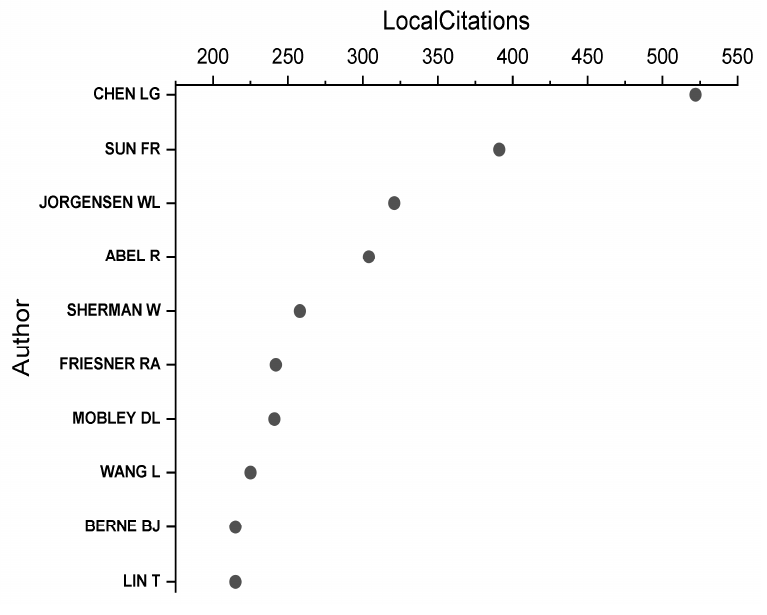
Figure 9. Most locally cited authors.